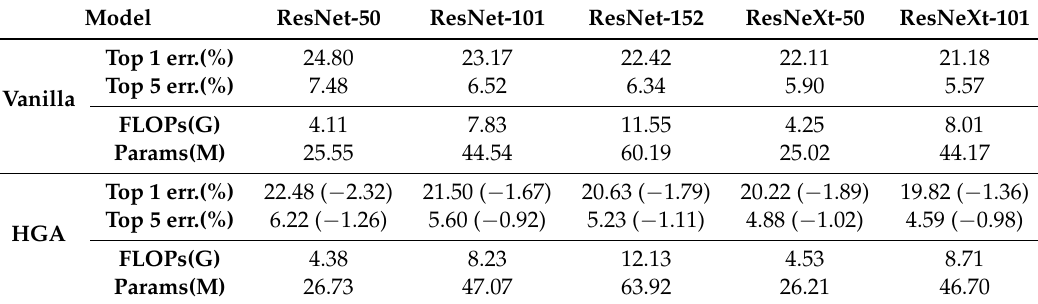
Table 2. Single-crop error rates of different models on ImageNet dataset.